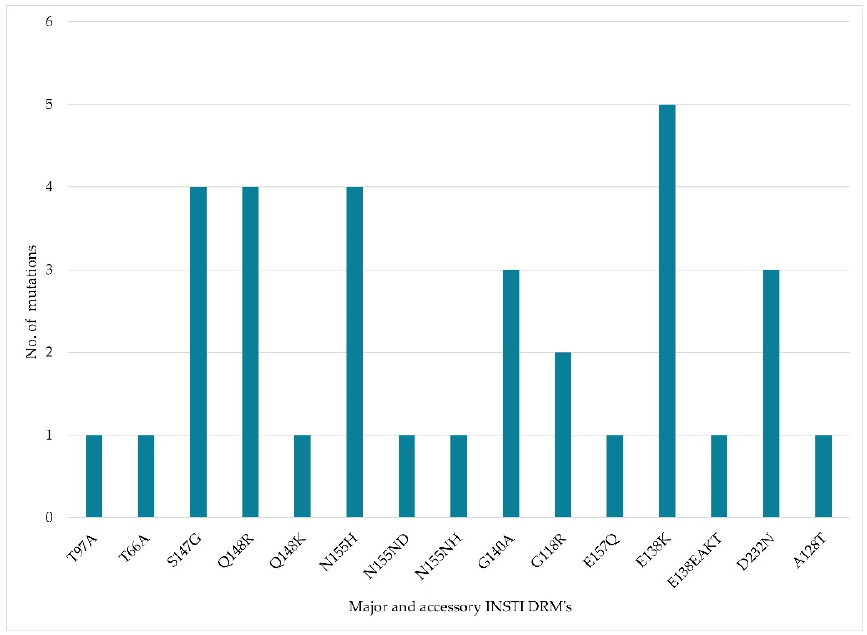
Figure 2. Prevalence of INSTI DRM in the 11 HIV-1C Integrase sequences from treatment-experienced individuals with virological failure whilst on dolutegravir/INSTI based therapy. INSTI, integrase strand transfer inhibitor, DRMs drug resistance mutations.